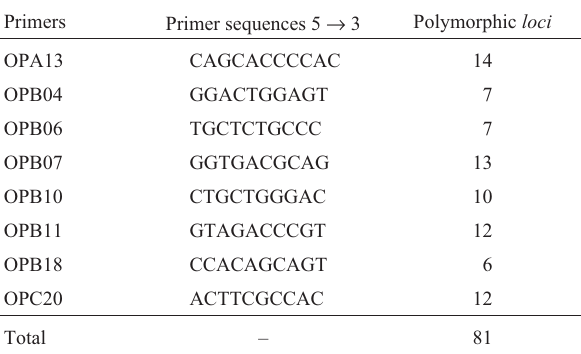
Table 2 - Random amplified polymorphic DNA (RAPD) primers, primer sequences and the number of polymorphic loci used in the population study of Eupemphix nattereri from Central Brazil